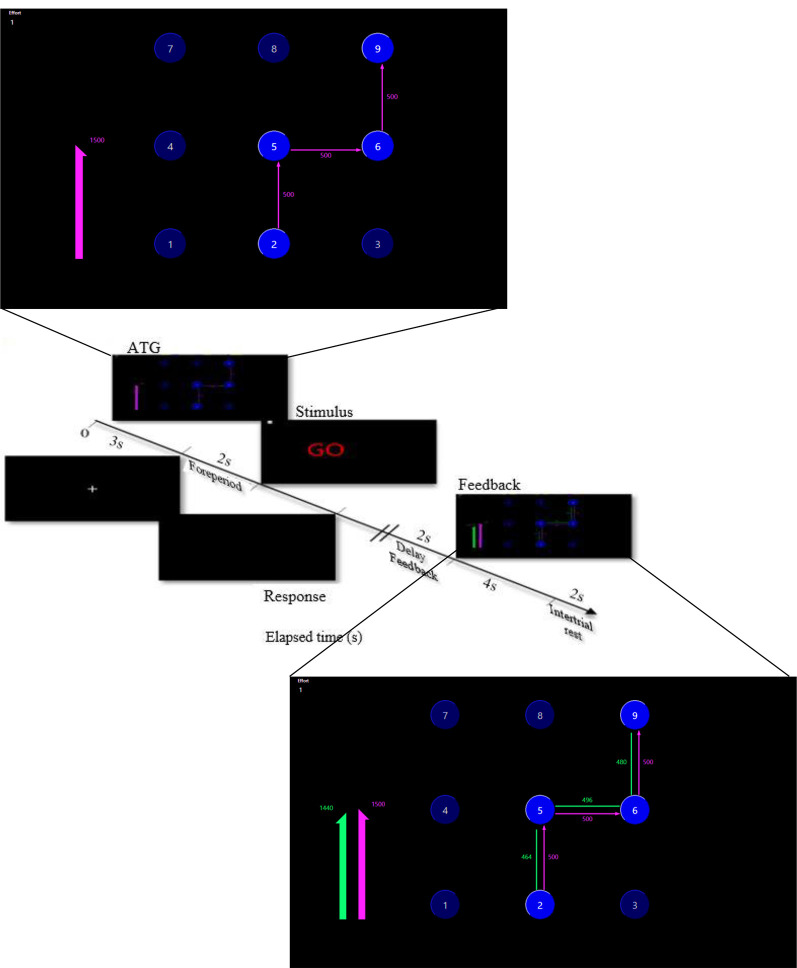
Procedure of one trial.